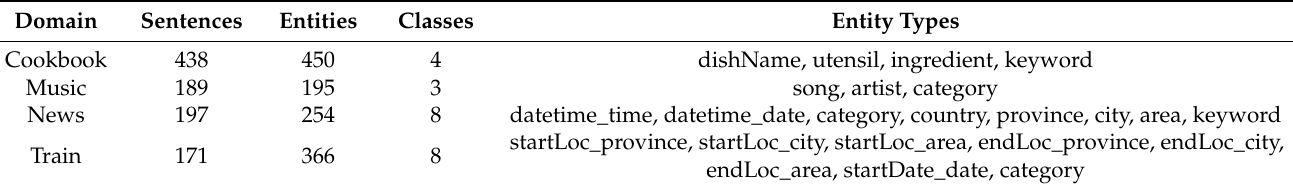
Table 2. SMP2020 subdomain